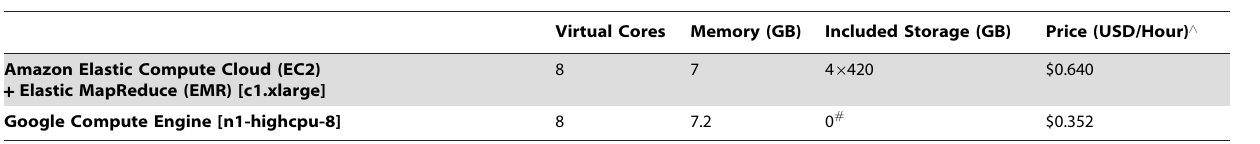
Table 2. Specification of used computational nodes for each system.